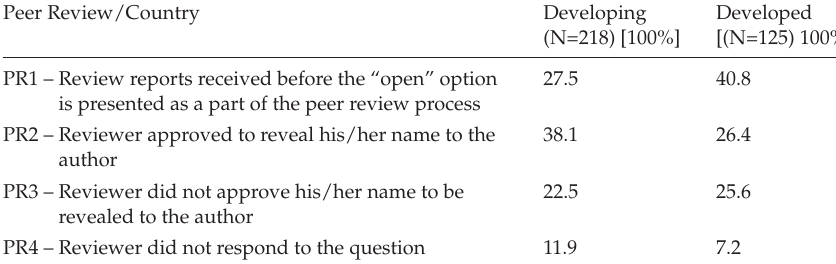
Table 8: Recommendations in the review reports and the country of the reviewers’ institutional affiliation [%].